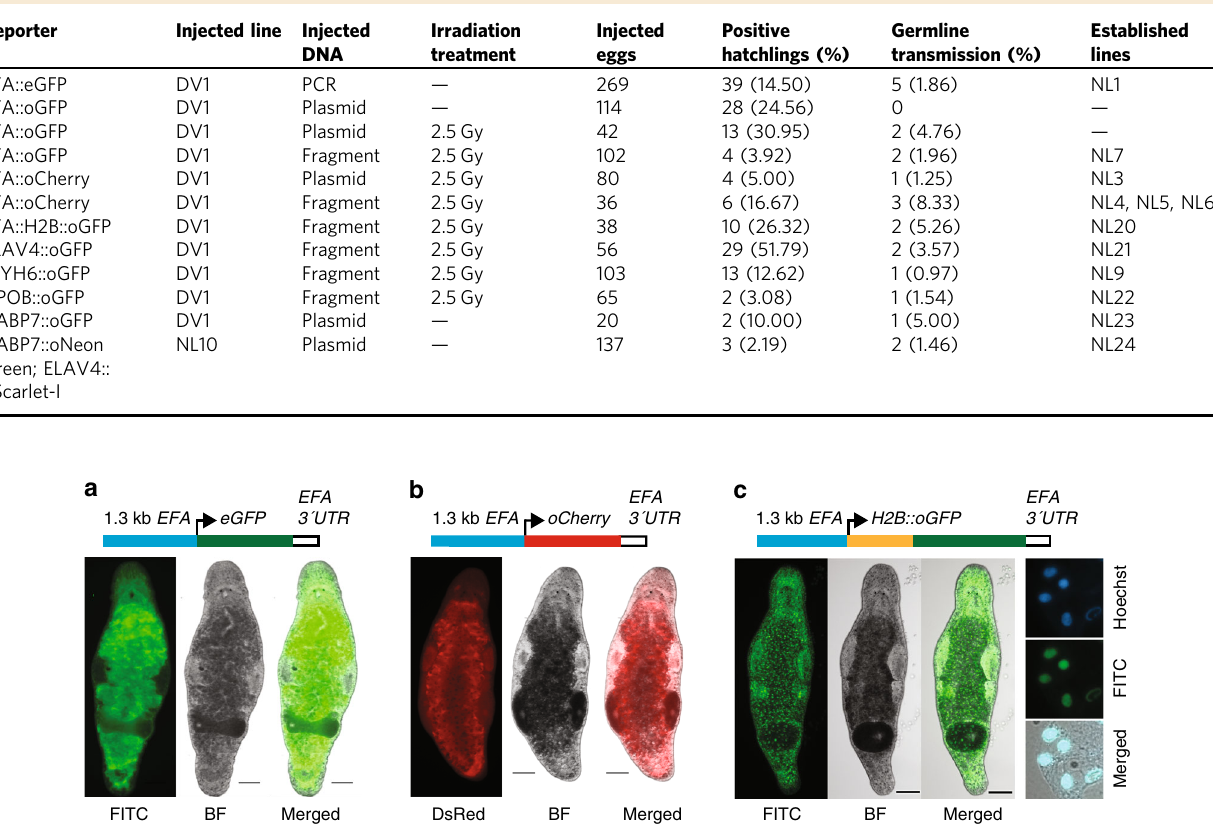
Fig. 2 Ubiquitously expressed elongation factor 1 alpha promoter transgenic lines. a NL1 line expressing enchanced GFP (eGFP). b NL3 line expressing codon-optimized Cherry (oCherry). c NL20 line expressing codon-optimized nuclear localized H2B::oGFP fusion. Right column — single cells from a macerated animal showing nuclear localization of GFP. FITC — FITC channel; DsRed — DsRed channel; BF — bright- fi eld; Hoechst — DNA staining by Hoechst. Scale bars are 100 μ m